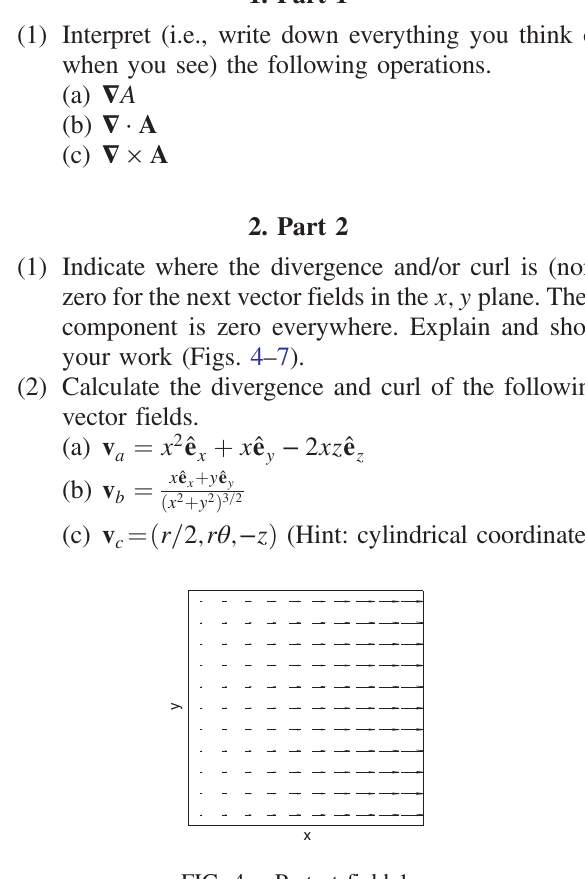
FIG. 8. Post-test field